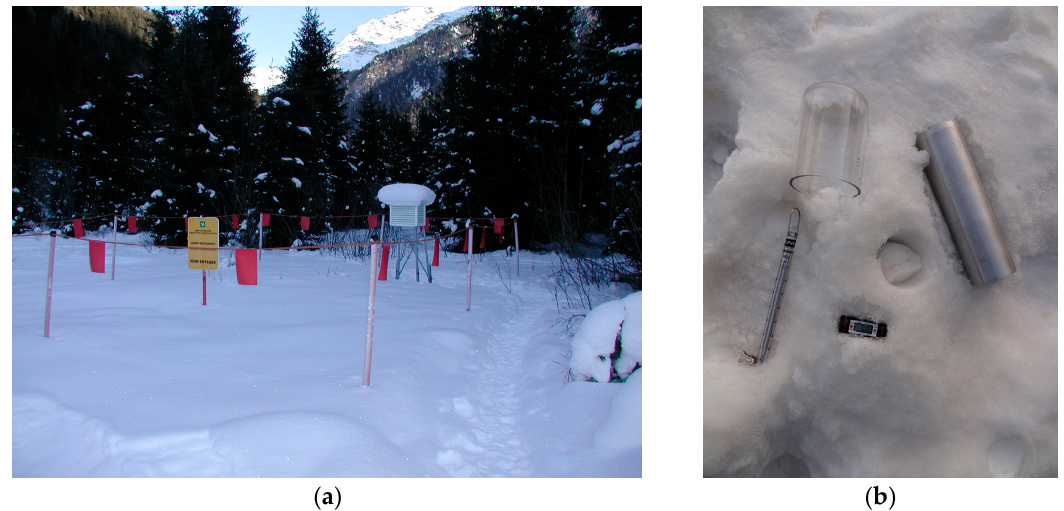
Figure 4. ( a ) S. Caterina Valfurva manual monitoring site; and ( b ) instruments for the direct manual measurement of snow water equivalent: snow sampler and